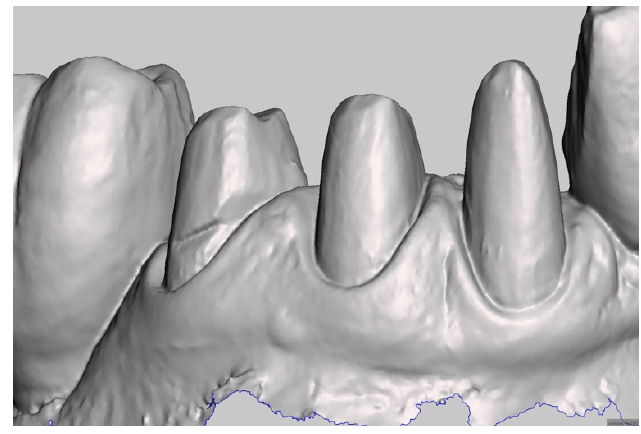
Figure 3. Provisional restorations made in composite.